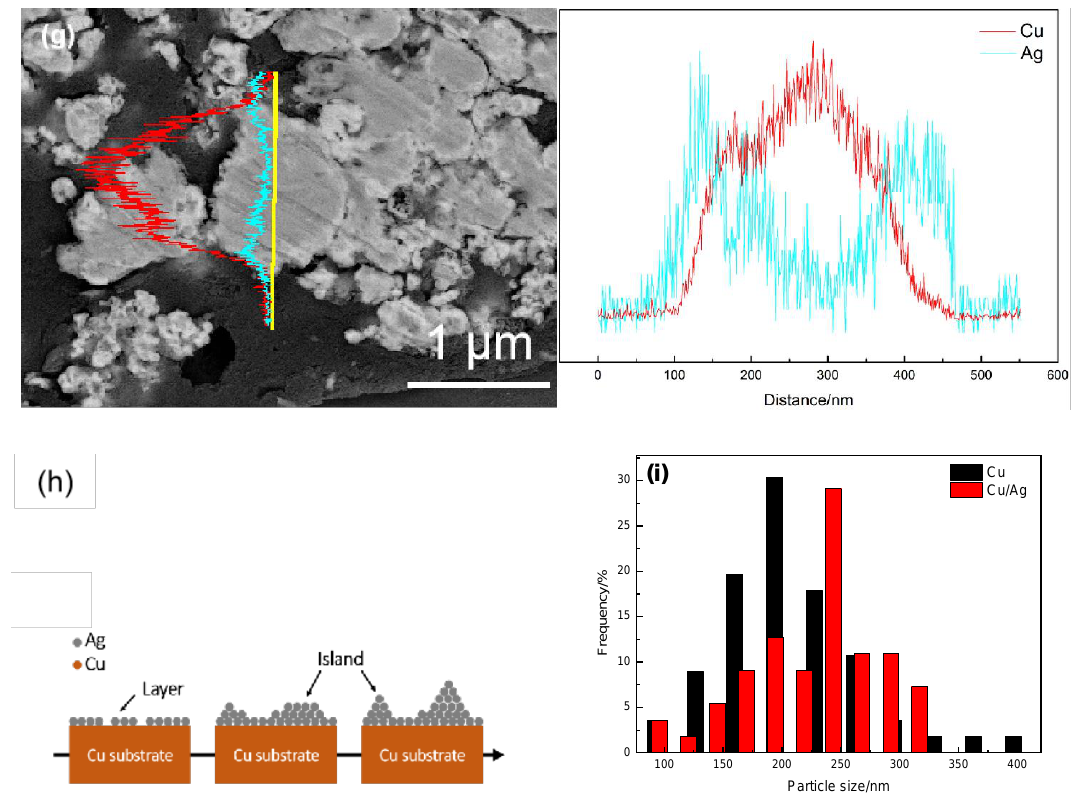
Figure 1. ( a ) Scanning electron microscope (SEM) image of Cu particles; ( b ) an SEM image of Cu / Ag core-shell composite; ( c ) X-ray di ff raction (XRD) patterns of Cu particles and Cu / Ag core-shell composite; ( d ) a high magnification SEM image of Cu / Ag core-shell composite; ( e ) a transmission electron microscope (TEM) image of Cu / Ag core-shell composite; ( f ) SAED patterns of Cu / Ag core-shell composite; ( g ) an SEM cross-section image of Cu / Ag core-shell composite; ( h ) a schematic diagram of the growth mode of the silver coating; ( i ) the particle size distribution of Cu and Cu / Ag core-shell composite.